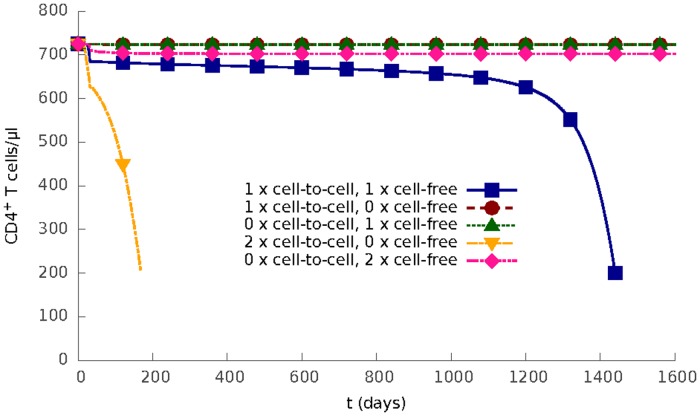
Two modes of HIV-1 infection.The density of CD4+ T cells as a function of time for different values of cell-to-cell infection rate β
1 and cell-free infection rate β
2: (1) both use their default value, (2) β
1 uses its default value and β
2 = 0, (3) β
1 = 0 and β
2 uses its default value, (4) β
1 is twice its default value and β
2 = 0, (5) β
1 = 0 and β
2 is twice its default value.